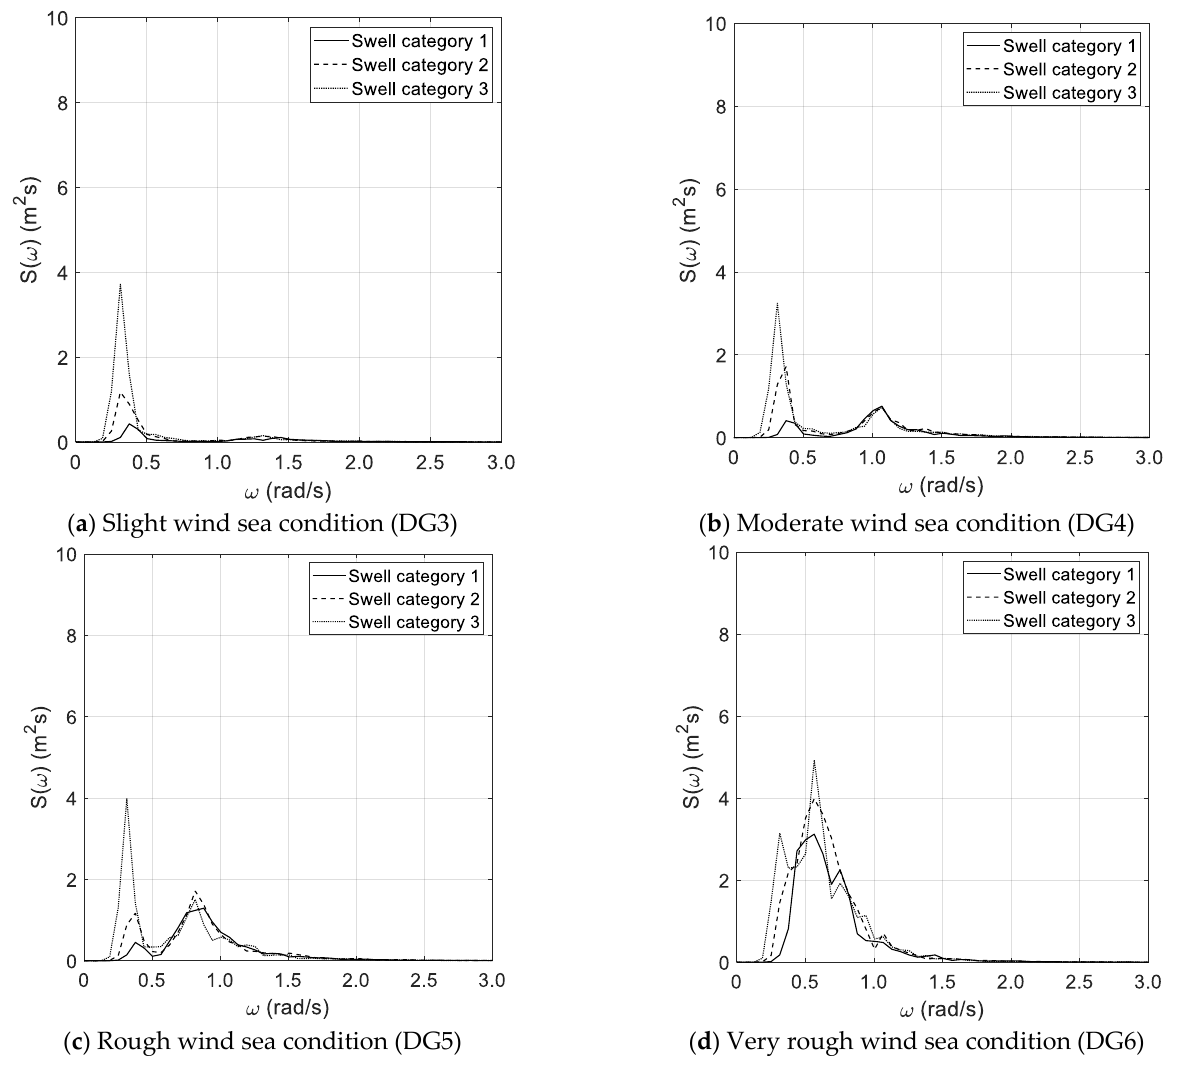
Figure 6. Spectral analysis (Welch)—short duration with low frequency resolution. The assessment of sea state parameters was performed via the NLSM method men- tioned in Section 3.3. The significant wave height, the wave peak period, the peak enhance- ment factor, and the spectral bandwidth of the assembled bimodal spectra, based on the Thomson and Welch methods, are reported in Tables 3 and 4, respectively, with reference to the long-time duration of 3600 s in terms of percentage variations regarding the initial input parameters. The assembled sea state parameters, based on the 600 s short time recording based on the Thomson methods combined with low and high frequency resolution are listed in Tables 5 and 6, respectively. Similarly, the sea state parameters, based on the sea spectra obtained by the Welch method are reported in Tables 7 and 8. It must be pointed out that sea state condition corresponding to DG 6 was not analyzed because the duration of 600 s was not sufficient to achieve a reliable assessment of sea state